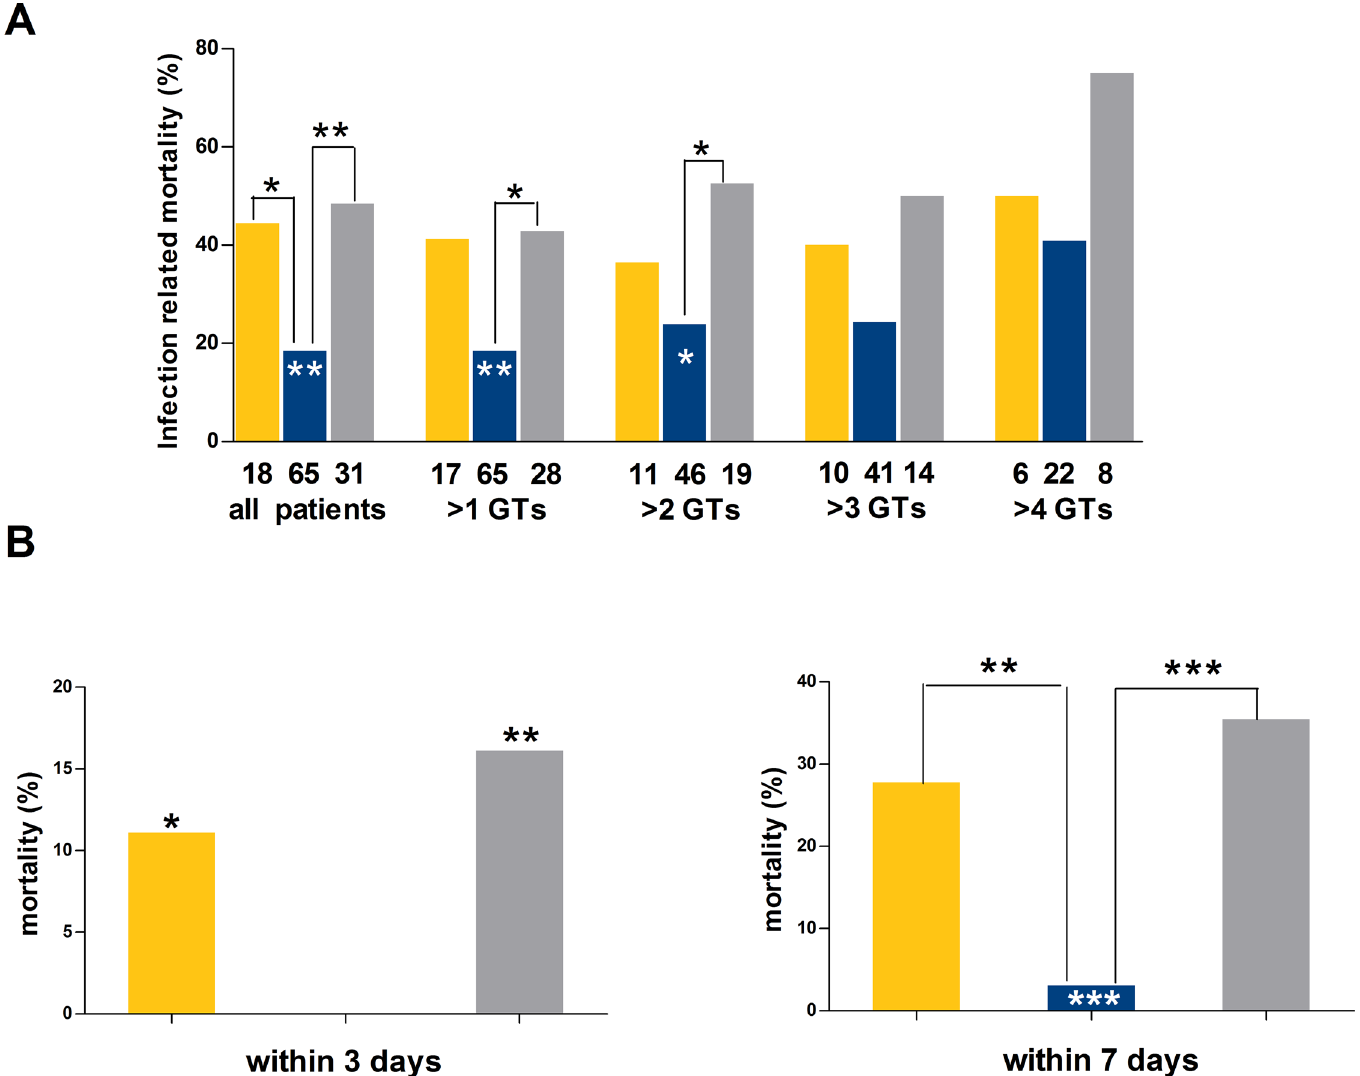
Fig 1. Infection-related mortality in patient grouped according to the median dose of granulocyte received. A) Mortality rate according to the number of granulocyte transfusions received. B) Mortality rate according to the time elapsed from the first granulocyte transfusion. Yellow bars represent patients in the low-dose group (median PMN dose inferior to1.5x10 8 /Kg), blue bars represent patients in the standard-dose group (median PMN dose 1.5 – 3.0x10 8 /Kg) and grey bars represent patients in the high-dose group (median PMN dose greater than 3.0x10 8 /Kg). White asterisks refer to standard-dose versus non- standard dose groups. * p < 0.05; ** p < 0.001.